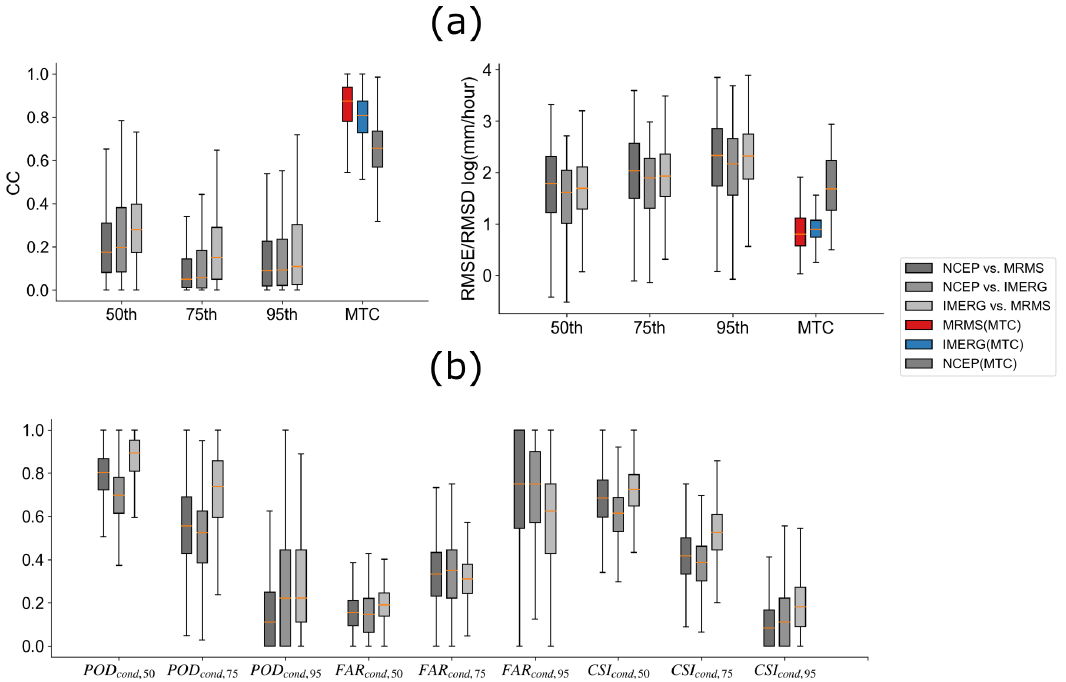
Figure 8. Boxplot of metrics conditioned at 50, 75, and 95 percentiles in the core region: ( a ) Continuous indices; ( b ) Categorical